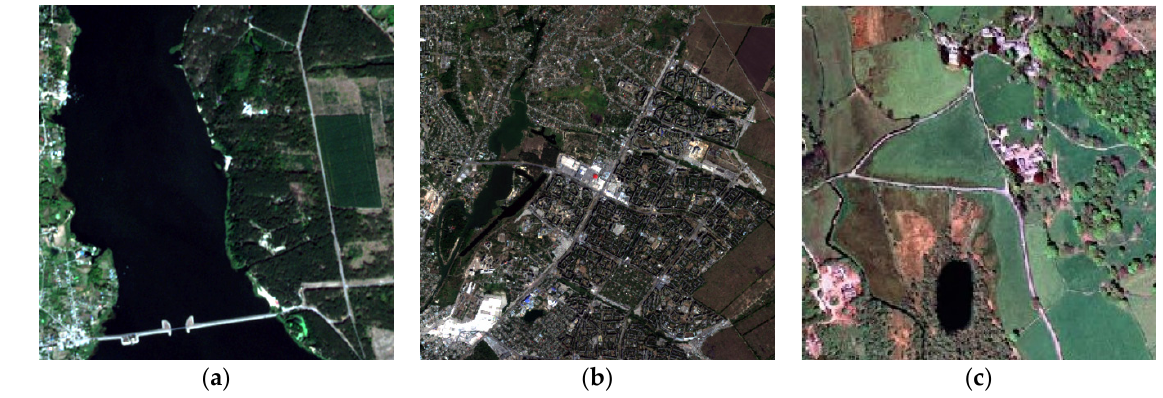
Figure 20. Processed fragments of Sentinel-2 ( a , b ) and Landsat ( c ) three-channel images. Table 18. Total probabilities of correct classification for depth 2 and different MAD for the image in Figure 20a using ML and NN classifiers.